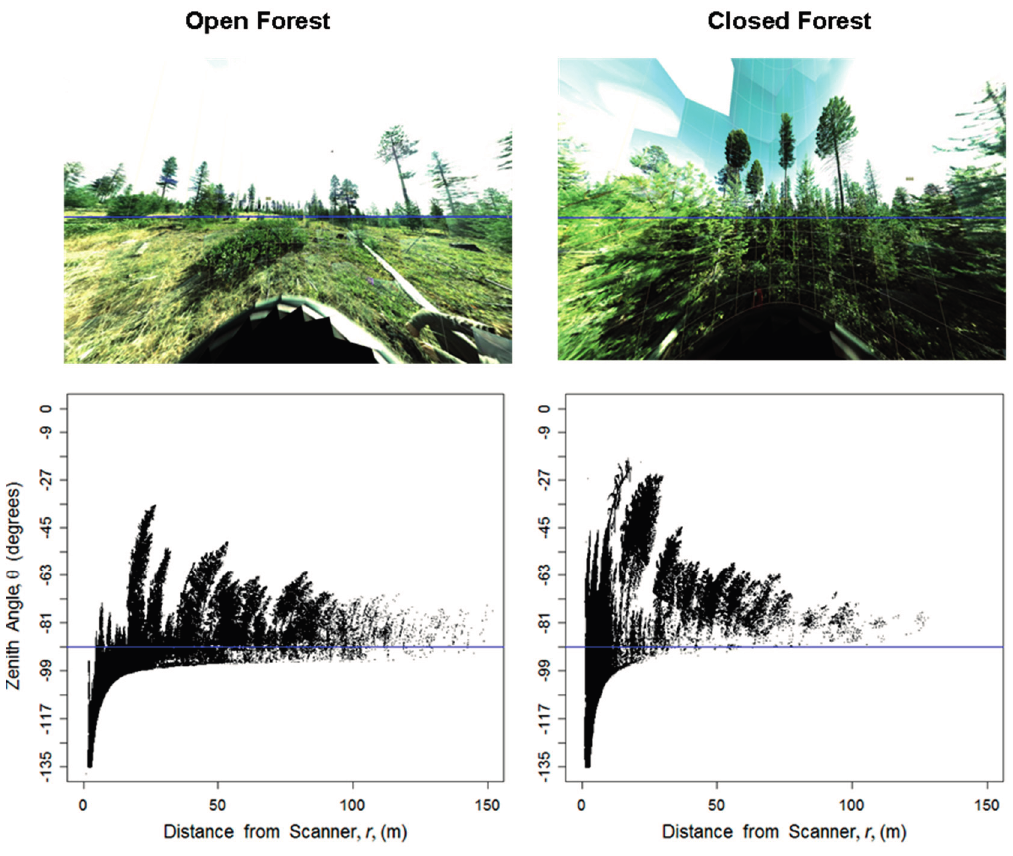
Figure 1. Visualizations of two representative plots, an open forest plot ( left ), and a closed forest plot ( right ). The top rows show a photo-mosaic, captured by the TLS scanner, at each plot location. The bottom row shows all points collected by the TLS instrument plotted with their distance from the scanner, r , on the horizontal axis and zenith, θ , on the vertical axis. Note that the blue lines correspond to − 90° of zenith angle (parallel to